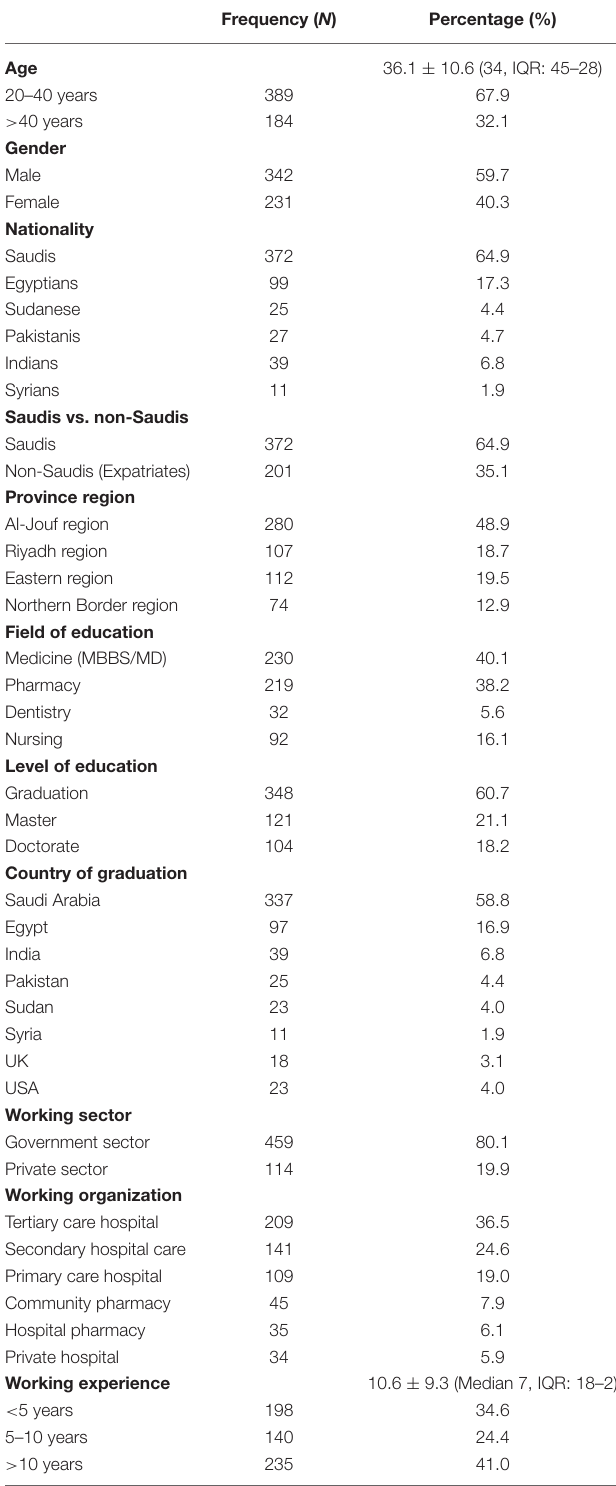
TABLE 1 | Demographics of study participants ( n =